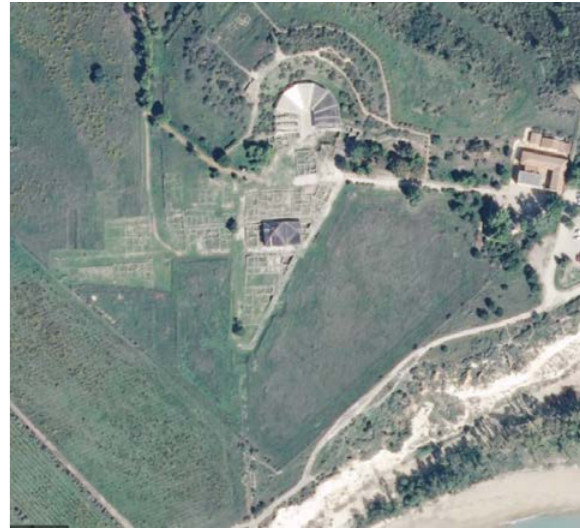
Figure 2. Area of Eraclea Minoa archaeological site.